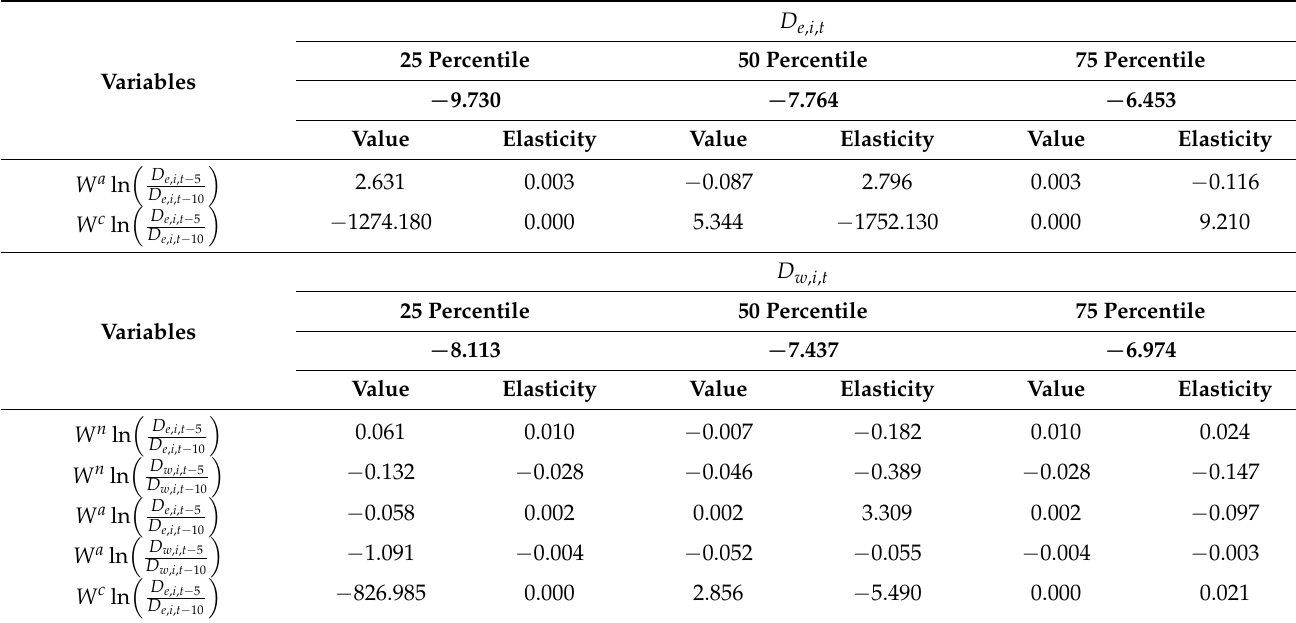
Table 3. Elasticities for job and worker densities.